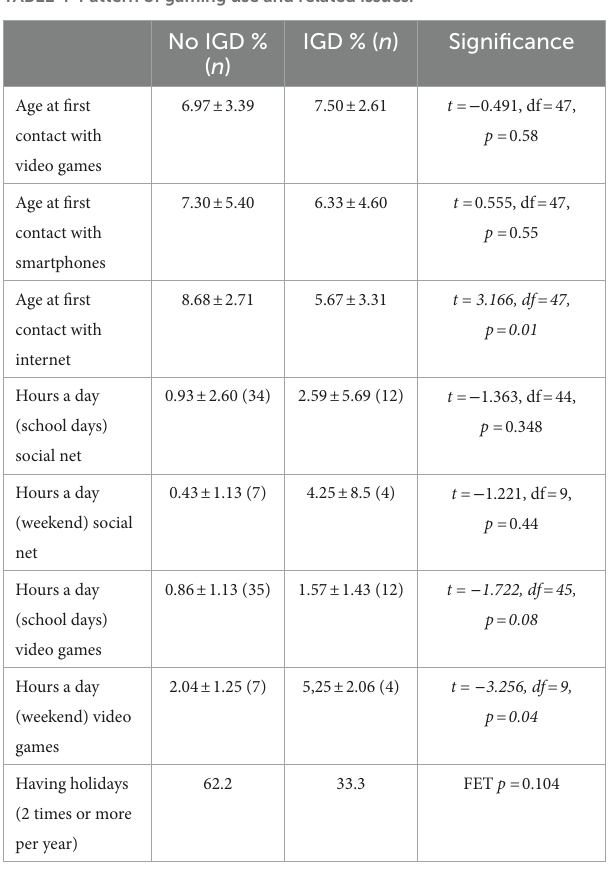
TABLE 4 Pattern of gaming use and related